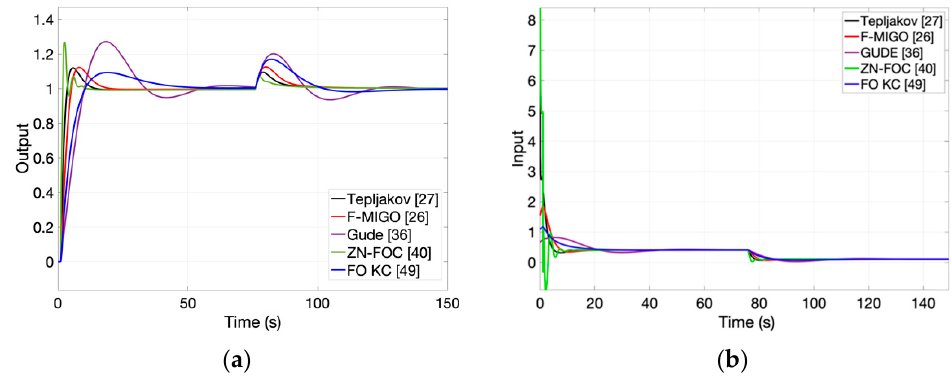
Figure 11. ( a ) Output signals for FO-PID control of lag-dominant process ( b ) Input signals for FO-PID control of lag-dominant process. Controllers tuned according to [26,27,36,40,49]. Table 3. Closed-loop results obtained with the FO-PID controller for the lag-dominant process. Controller Overshoot Settling Time FO-PID Tepljakov [27] 12% 11.5 FO-PI F-MIGO [26] FO-PI Gude [36]